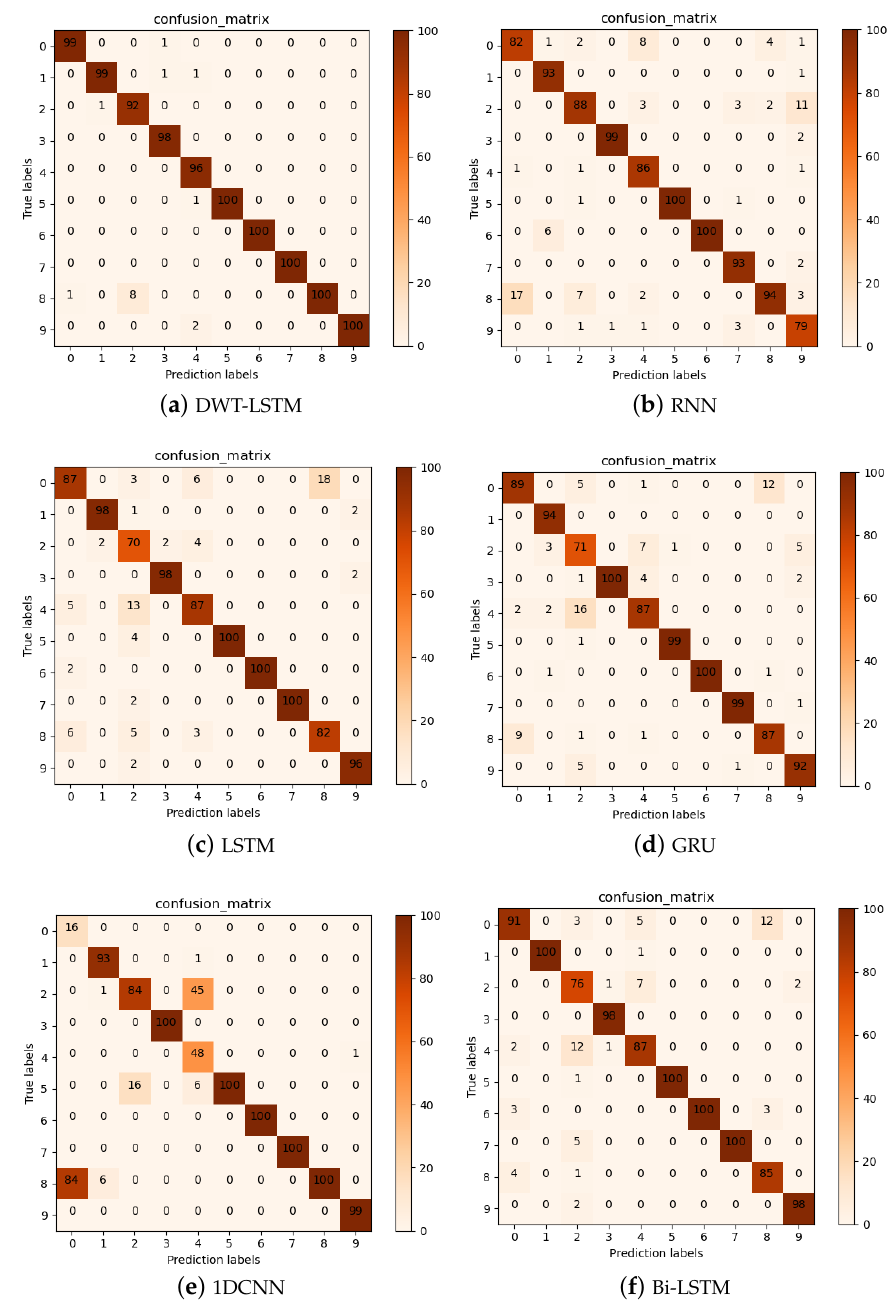
Figure 8. Confusion matrix of fault diagnosis results by different